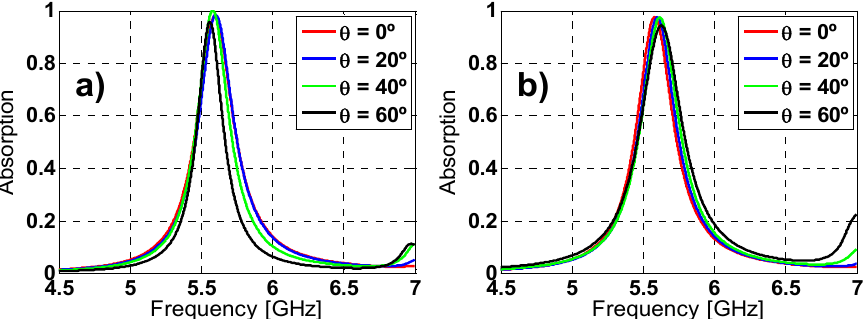
Figure 7. Absorption simulation results for different polarization angles ( ϕ ) of the incident field for both ( a ) TE and ( b ) TM polarizations.